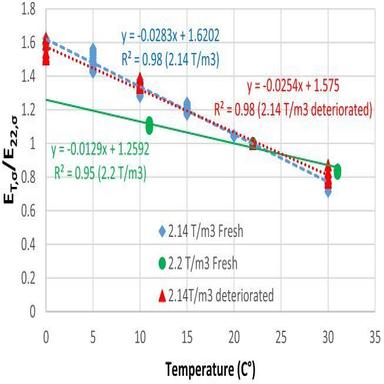
Relationship between ET,σ/E22 and temperature (3% bitumen content and 2% hydrated lime content).